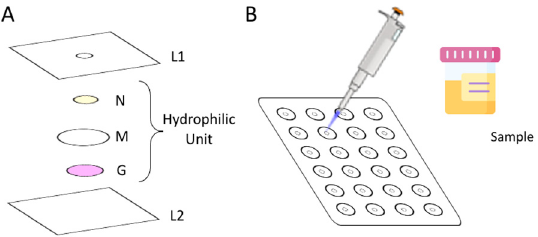
Figure 1. Schematic representation of: ( A ) the μ PAD unit assembly and ( B ) sample insertion.